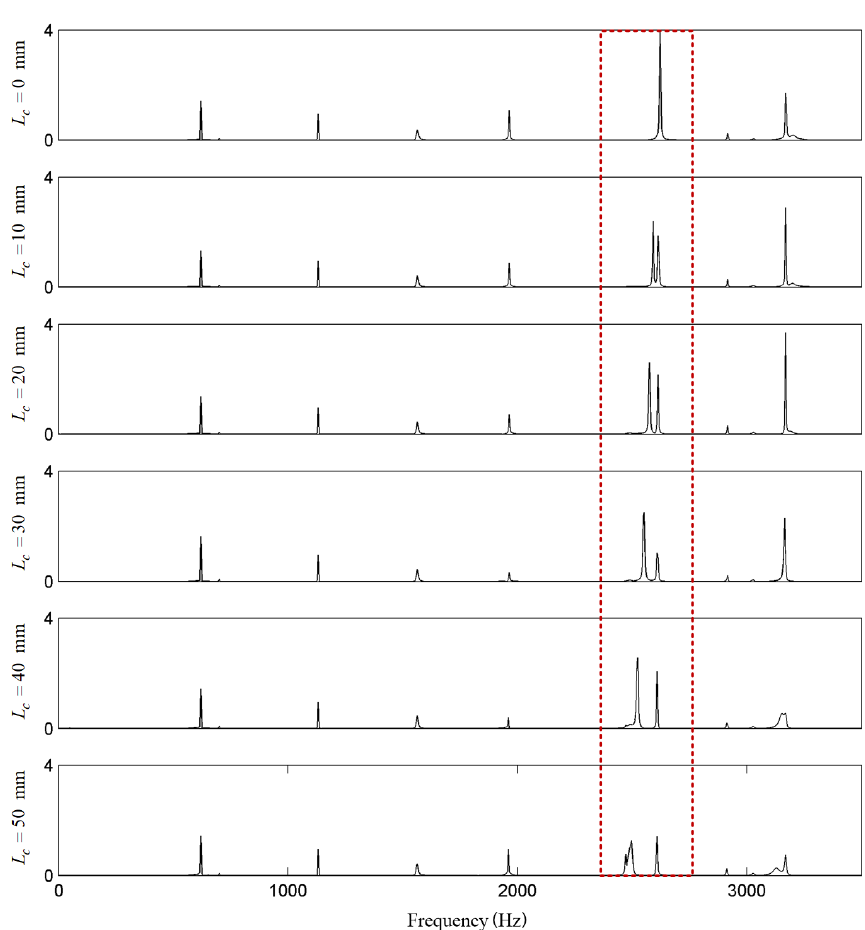
Figure 13. Comparisons of the frequency response functions with different lengths of a crack in the impeller. L c denotes the length of the